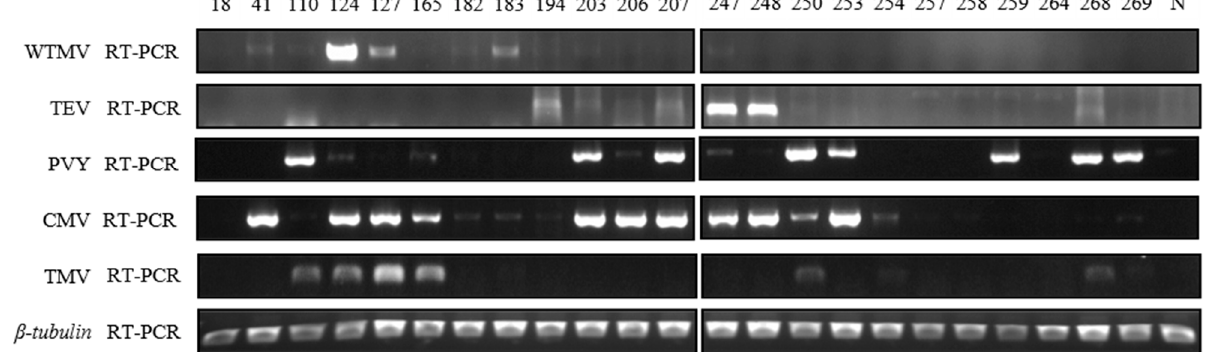
Figure 4. RT-PCR detections of various tobacco viruses in Nicotiana tabacum samples collected from fields in Henan Province. The samples are chosen based on the preliminary screen using Western blotting. The sample numbers correspond to the former experiment. The “N” sample was obtained from healthy tobacco and used as a negative control. β -tubulin is used as the internal control for RT-PCR.